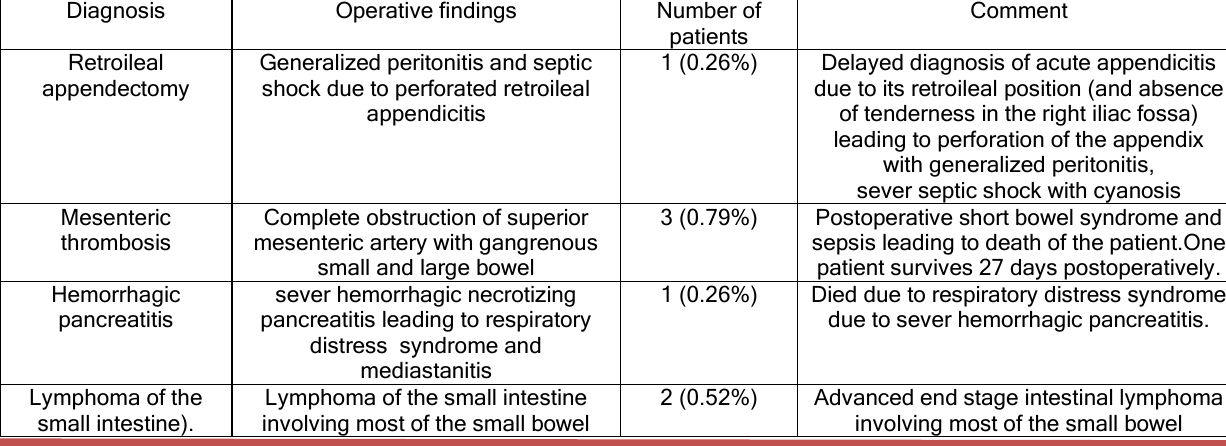
Table (4): Shows postoperative mortality and operative findings in Group B